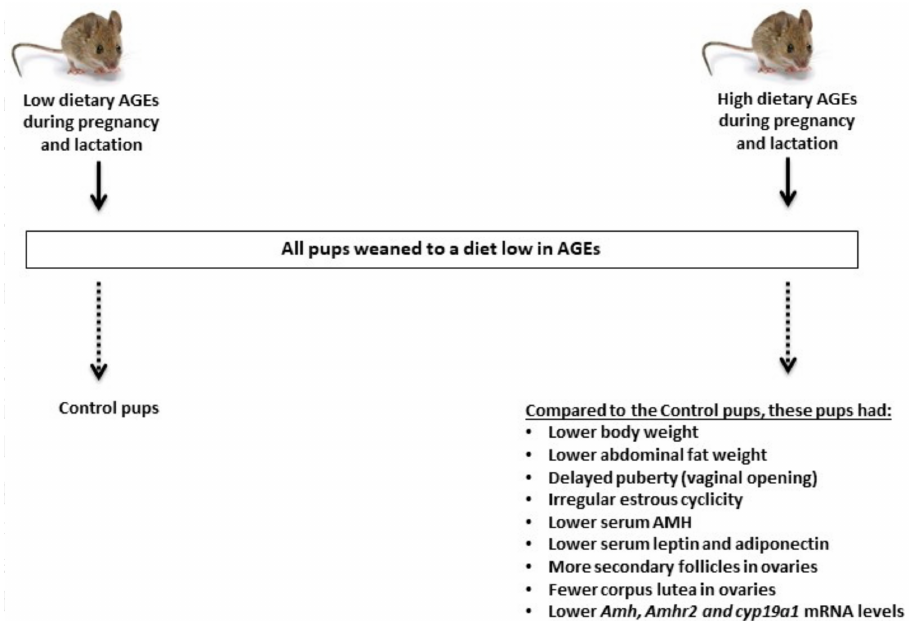
Figure 4. Effect of high dietary AGEs during pregnancy and lactation on reproduction in offspring. Perinatal exposure to high dietary AGEs affects the growth of the offspring as well as the onset of puberty, estrous cyclicity, and ovarian follicular development, including ovulatory events. In addition, perinatal exposure to high dietary AGEs causes the lower expression of ovarian genes involved in folliculogenesis ( Amh and its receptor Amhr2 ), and steroidogenesis ( Cyp19a1 , which is an aromatase enzyme responsible for conversion of testosterone to estradiol), as well as lower serum AMH levels, which are a marker of ovarian reserve [88]. Antimullerian hormone (AMH), anti-mullerian hormone receptor (anti-mullerian hormone receptor), messenger RNA